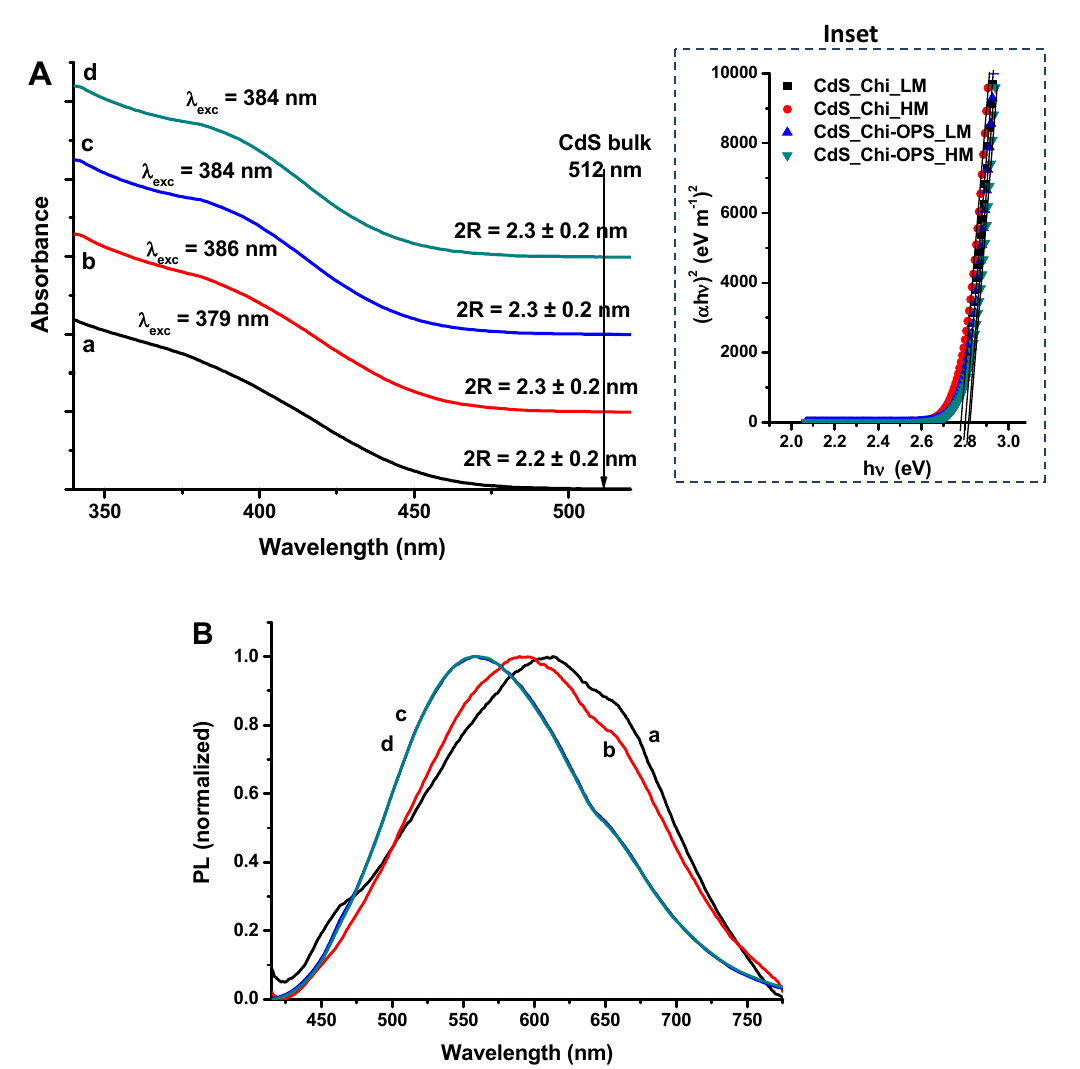
Figure 1. ( A ) UV–Vis and ( B ) PL spectra of (a) QD_Chi_LM, (b) QD_Chi_HM, (c) QD_Chi-OPS_LM, and (d) QD_Chi- OPS_HM. Inset: TAUC relation for CdS QDs. ((c) and (d) spectra are overlapped in PL graph). The QDs’ PL spectra were measured at room temperature and stabilized. Chi and